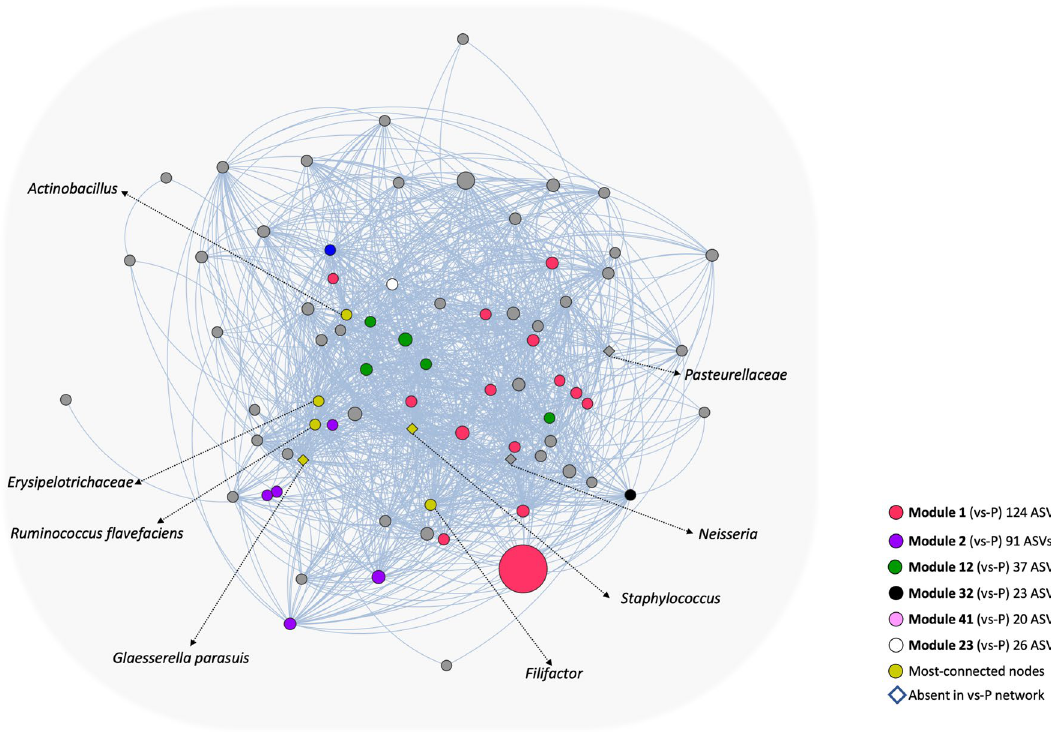
positive correlations between the different nodes. The nodes are colored based on the location of these ASVs in the network of the nasal microbiota composition of piglets from vaccinated sows (vs-P) modules. ASVs, in this module 6 from the cs-P network, that are present as the top ten most-connected nodes in the vs-P network, are represented in different colors regarding the modules they belong in the vs-P network: red, nodes in vs-P module 1; green, nodes in vs-P module 12; purple, nodes in vs-P module 2; black, node in vs-P module 32, and pink, for node in module 4. Yellow color highlights the most connected nodes in this module 6 from the cs-P network (6 nodes). The white node corresponds to an ASV classified as Erysipelotrichaceae, which is located in the same module as a G. parasuis ASV in the vs-P network. Diamond shaped nodes correspond to the four nodes that were absent in the vs-P network. Size of the nodes are proportional to their relative abundance, ranging from 0.0039% ( Neisseria , one of the diamond shaped nodes) and 5.07% ( SMB53 , largest red-colored